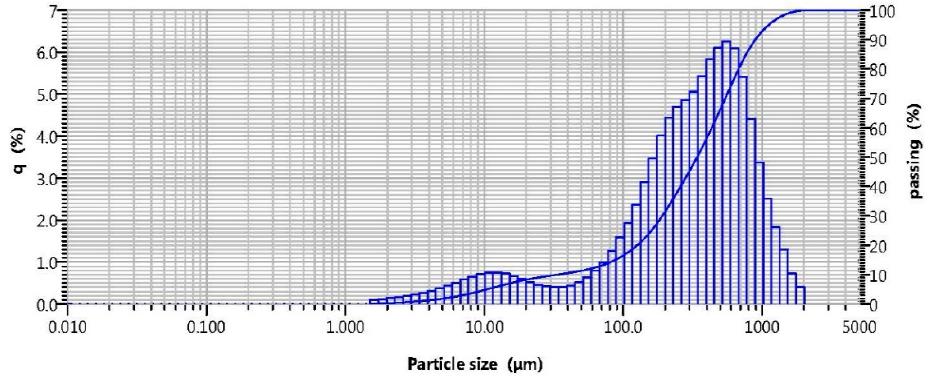
Figure 1. Granulometric composition of the OS particles.